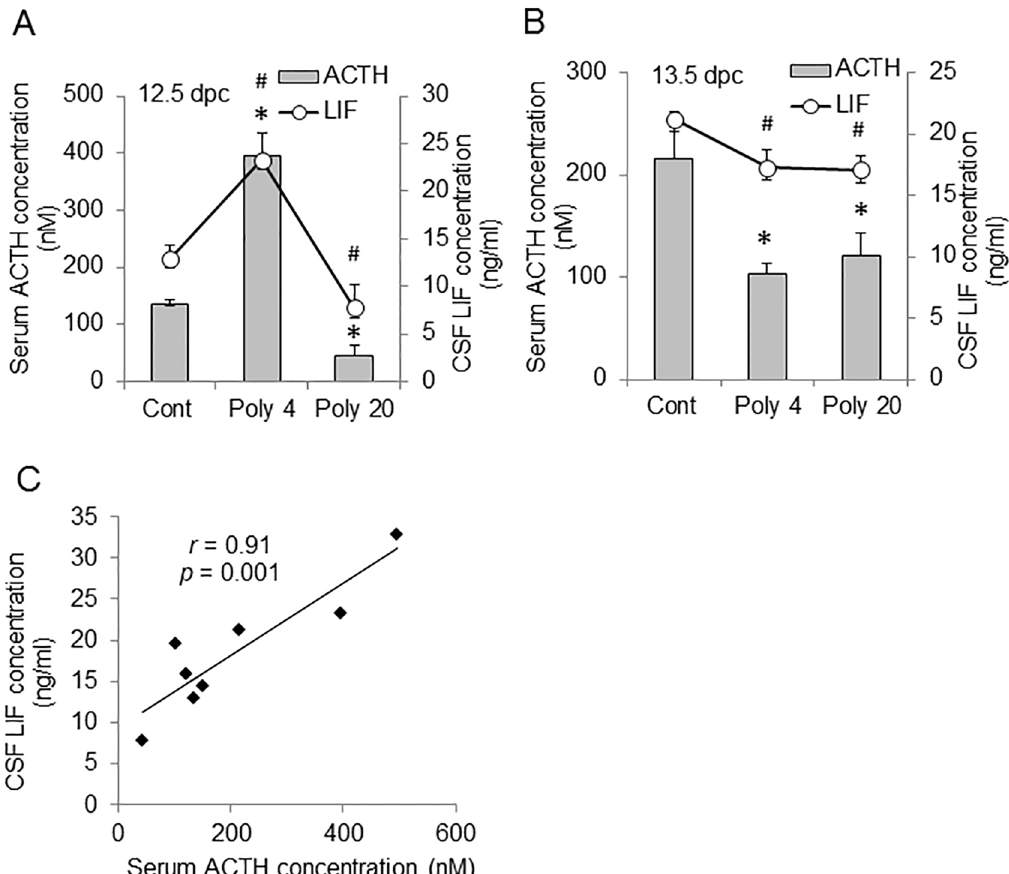
Fig 4. Alteration of fetal adrenocorticotropic hormone (ACTH) and leukemia inhibitory factor (LIF) levels by maternal immune activation (MIA). (A) Concentration of ACTH in fetal serum (FS) and LIF in fetal cerebrospinal fluid (CSF) at 3 h after MIA at 12.5 days post-coitum (dpc). (B) Concentration of ACTH in FS and LIF in fetal CSF at 13.5 dpc. (C) Correlation of LIF level in CSF and ACTH level in FS. MIA was induced by an intraperitoneal (i.p.) injection of 4 or 20 mg/kg polyriboinosinic-polyribocytidylic acid [poly (I:C)] at 12.5 dpc. Controls were injected with an equal volume of saline (0.01 ml/g body weight). Gray bars: ACTH concentration, open circles: LIF concentration. * , p < 0.05 vs. control in FS. #, p < 0.05 vs. control in CSF. Number of dams = 3 or 4 in each group. Error bars , SEM.